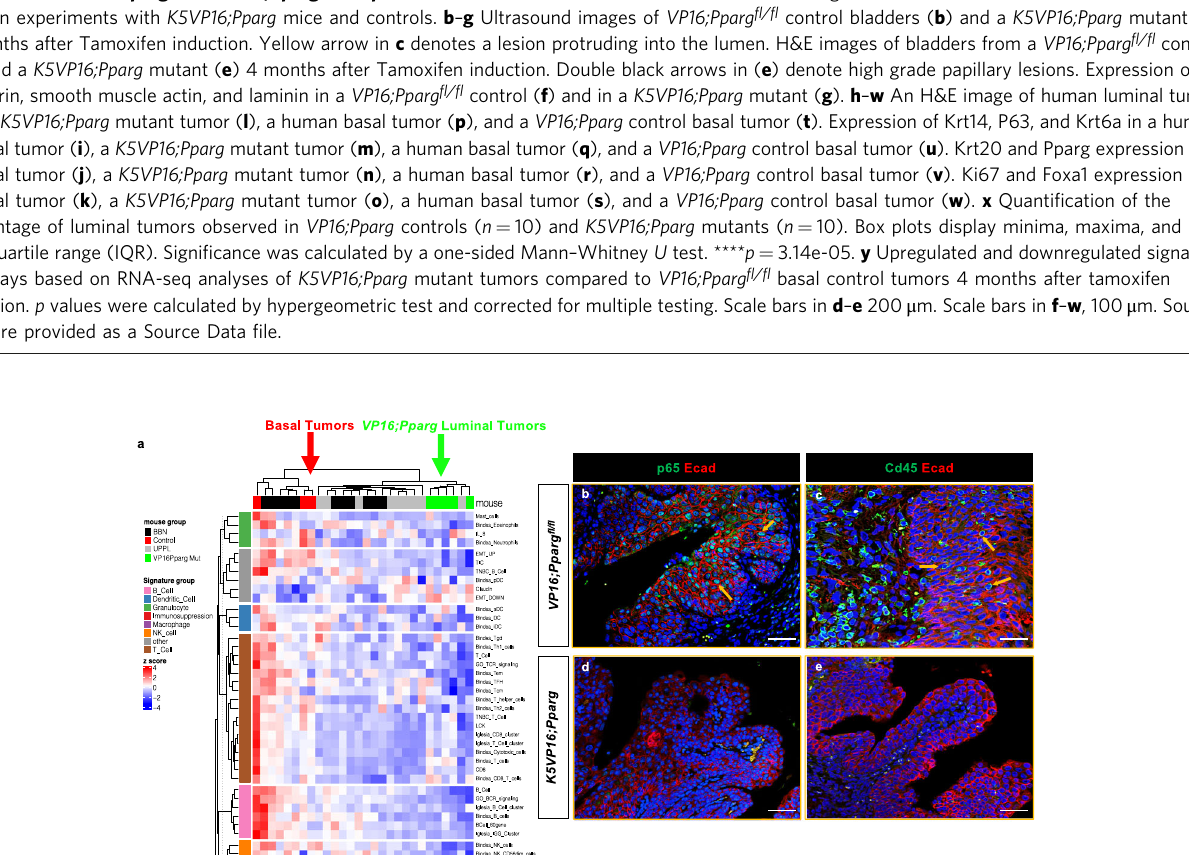
Fig. 4 K5VP16;Pparg tumors are immune cold. a Immune gene signatures of K5;mTmG control tumors, K5;VP16;Pparg;mTmG mutant tumors, tumors induced by BBN, and UPPL primary tumor samples. Expression of p65 and E-cadherin in controls ( b ) and in K5VP16;Pparg mutant tumors ( d ). Expression of Cd45 and Ecad in controls ( c ) and in K5VP16;Pparg mutant tumors ( e ). Yellow arrows in b and c denote p65 and Cd45-expressing cells in control tumors. Scale bars, 100 μ